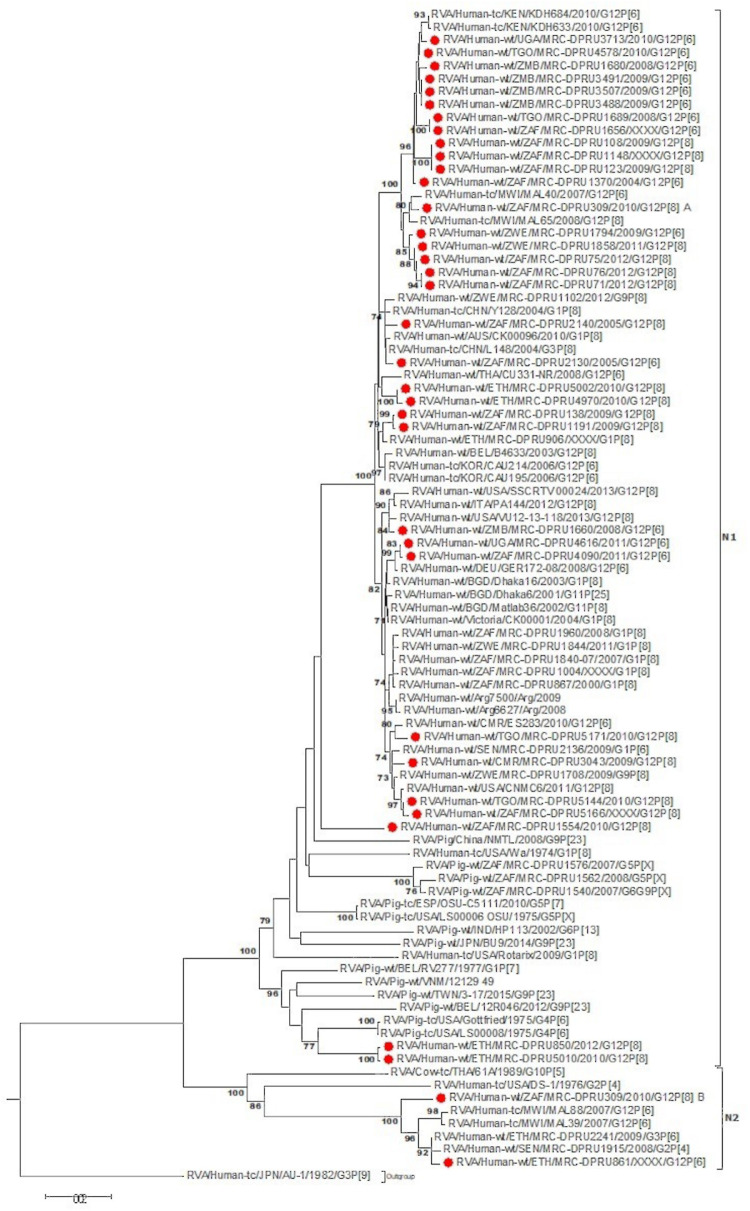
NSP2 maximum likelihood tree was constructed using the Hasegawa-Kishino-Yano model with gamma distribution and invariant sites the tree, African G12 study strains shown in red. Bootstrap values of ≥75% are not shown. Scale bars, 0.5 substitutions per nucleotide.